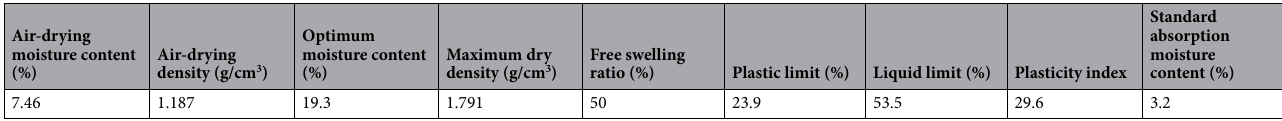
Table 1. Basic physical property indexes of expensive soil.